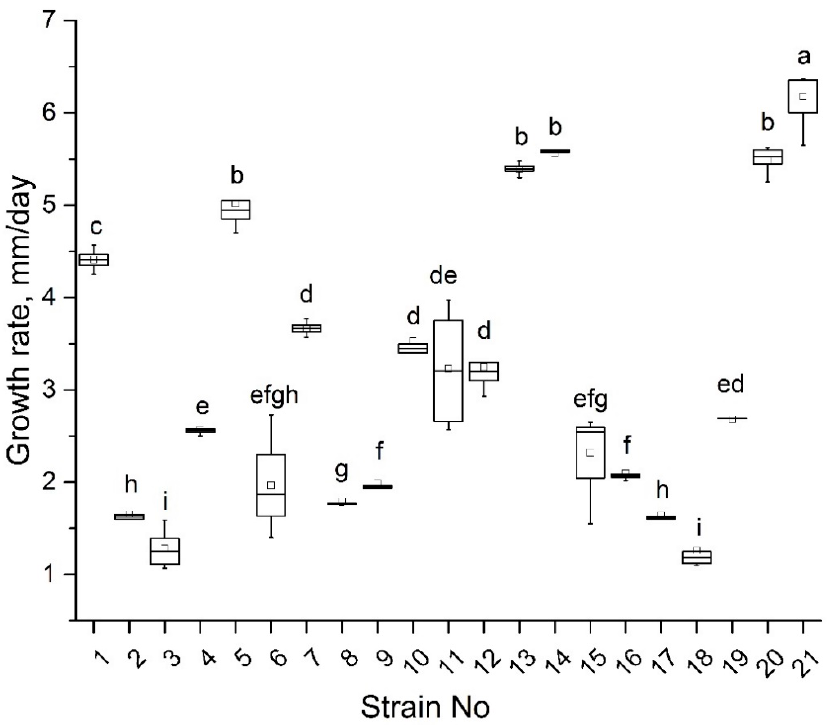
Figure 7. Growth rate of the isolated Microdochium sp. strains. Boxes that do not share the same letter have significantly different medians in pairwise comparison (Mann–Whitney test, p < 0.05). The experiment was performed in four biological replicates.